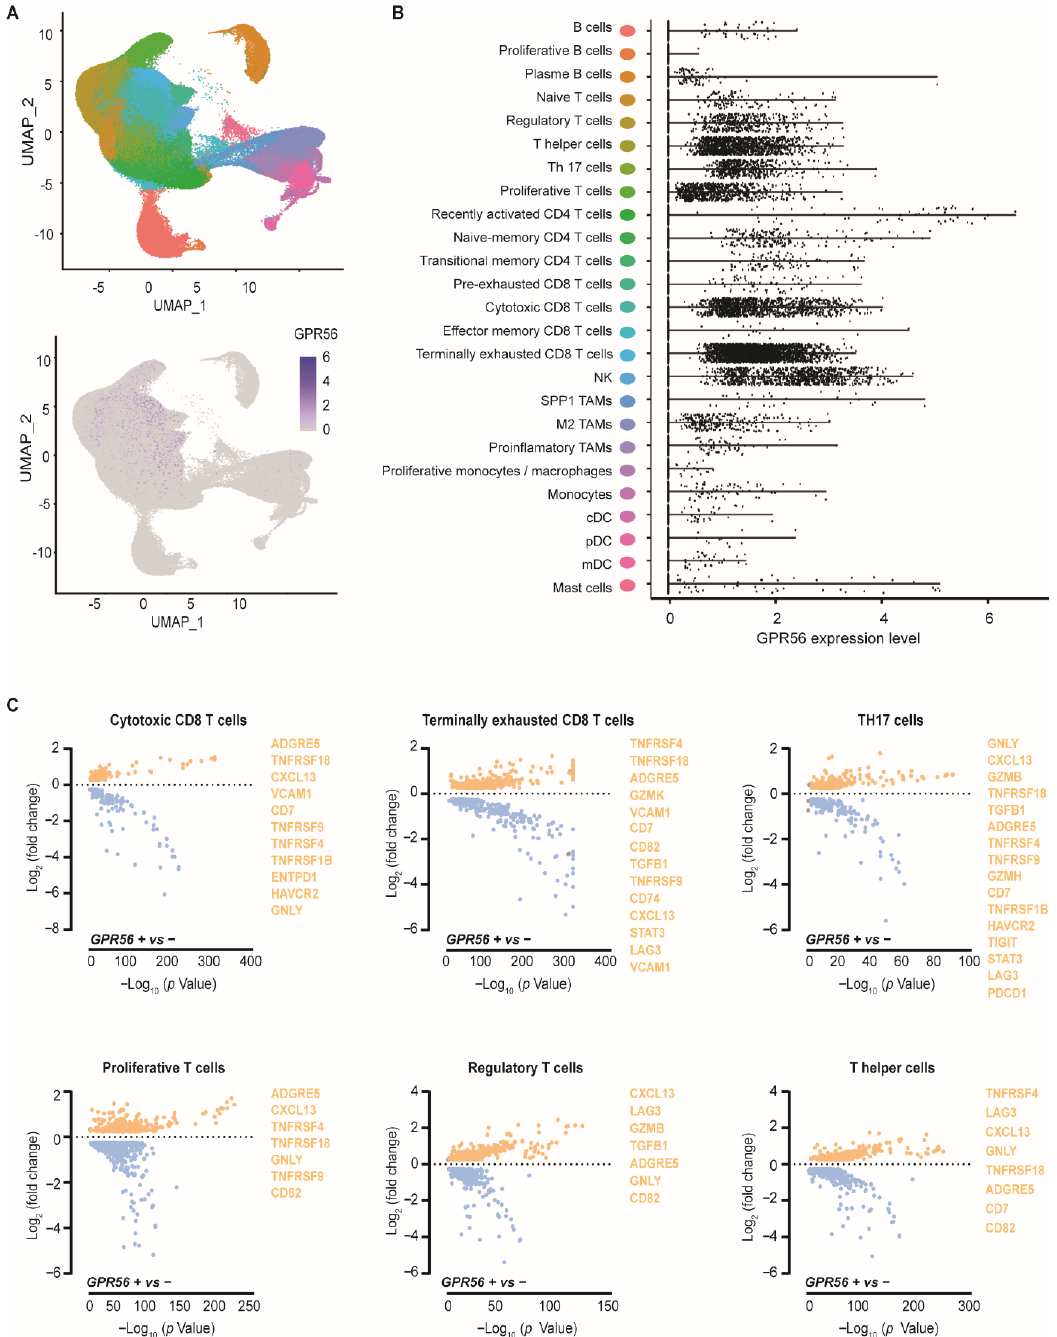
Figure 1. GPR56 is expressed in cytotoxic and terminally exhausted CD8 TILs that display a tumor- reactive phenotype across multiple tumor types. ( A ) Single-cell tumor immune atlas RNA sequencing data-set based on over 500,000 cells from 217 patients and 13 cancer types revealing GPR56 expression within different immune cell subtypes. Visualized by a UMAP representation and in a grouped analysis. ( B ) displaying the different GPR56 expressing tumor infiltrating immune-cell subtypes. ( C ) Differential gene expression of the GPR56-positive vs. GPR56-negative populations within the cytotoxic CD8 T cells, terminally exhausted CD8 T cells, TH17 cells, proliferative T cells, regulatory T cells and T helper cells fractions, calculated using FindMarkers function from Seurat with MAST as the method of choice. Genes with a p -value ≤ 0.05 and log2FoldChange ≥ 0.25 are displayed, visualized in volcano plots using GraphPad Prism 8. Several upregulated effector, (pre-)exhausted and tumor reactive genes are highlighted in